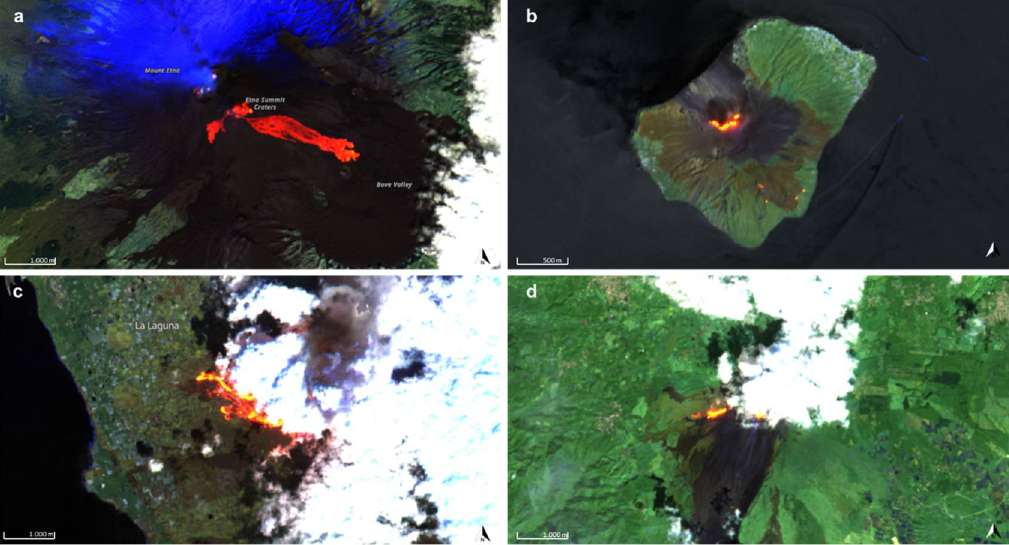
Figure 2. Sentinel-2 MSI TOA reflectance images used as the test set for the two models. False RGB (B12, B11, and B5) S2-MSI acquisition over ( a ) Mt. Etna—21 February 2021—( b ) Stromboli—27 July 2019—( c ) Cumbre Vieja—25 September 2021—and ( d ) Pacaya—31 October 2020.